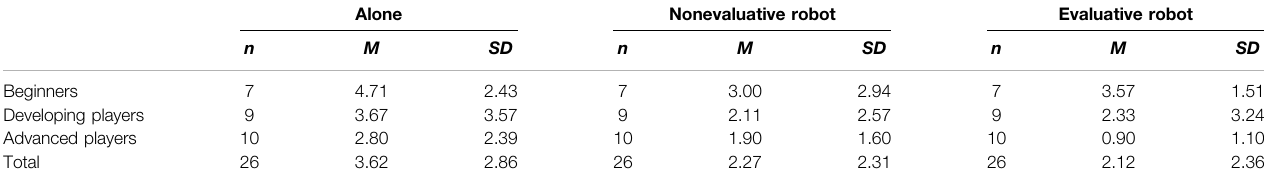
TABLE 5 | Mean and standard deviation of motivation measured as persistence collected by the behavior data in the alone, nonevaluative robot, and evaluative robot conditions. Videos with a bad quality were not analyzed (incomplete, too much noise, etc.). Alone